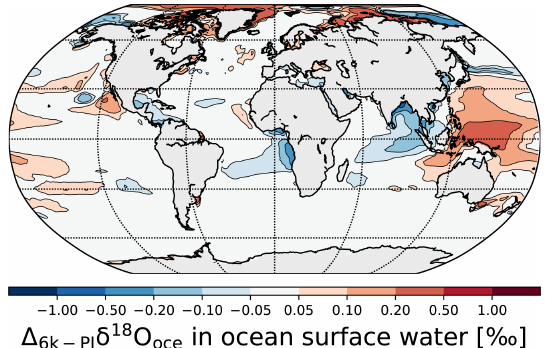
Figure 7. Modeled annual mean δ 18 O oce changes in ocean surface water between the mid-Holocene and PI